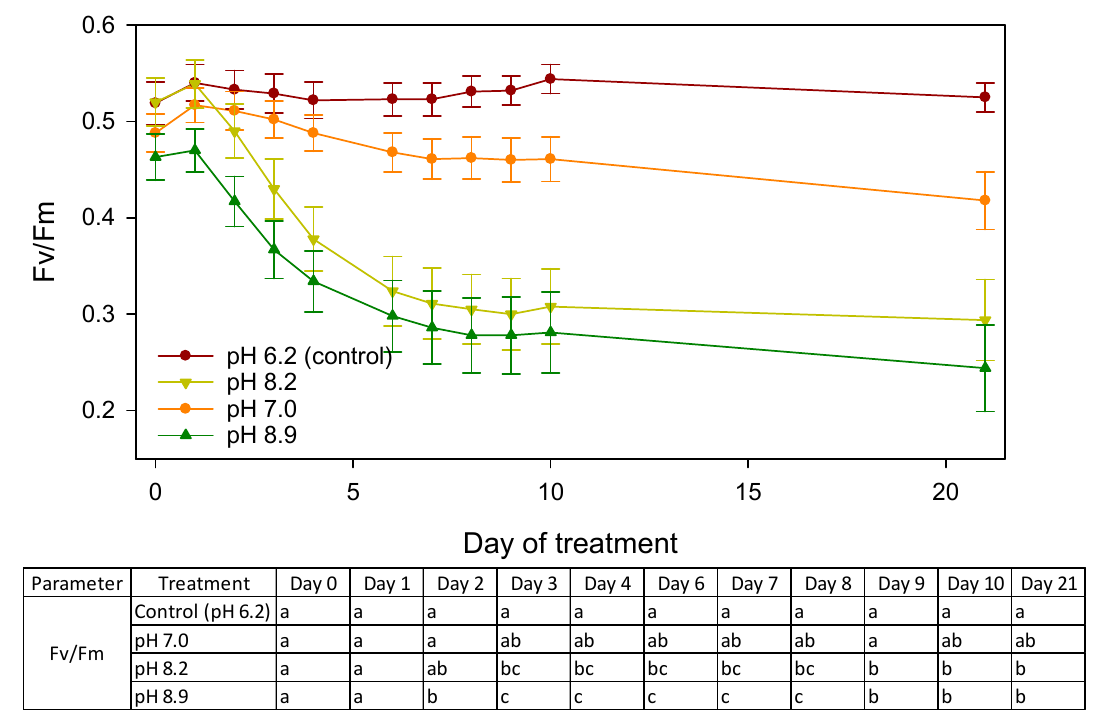
Figure 2. Time series of F v /F m (mean ± SE) of R. fortunei seedlings in response to different pH treatments. Different lower-case letters denote significant differences within a day according to